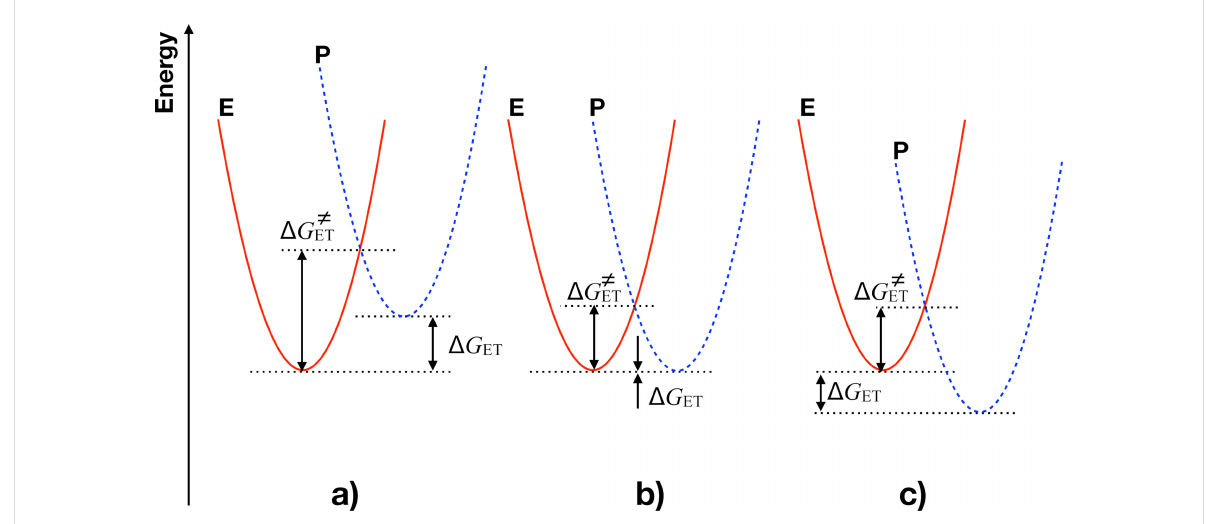
Figure 2: Photoinduced electron transfer under different scenarios in which each example exhibits an intrinsic activation barrier resulting in threshold systems a) endothermal conditions, b) thermoneutral conditions, c)exothermal